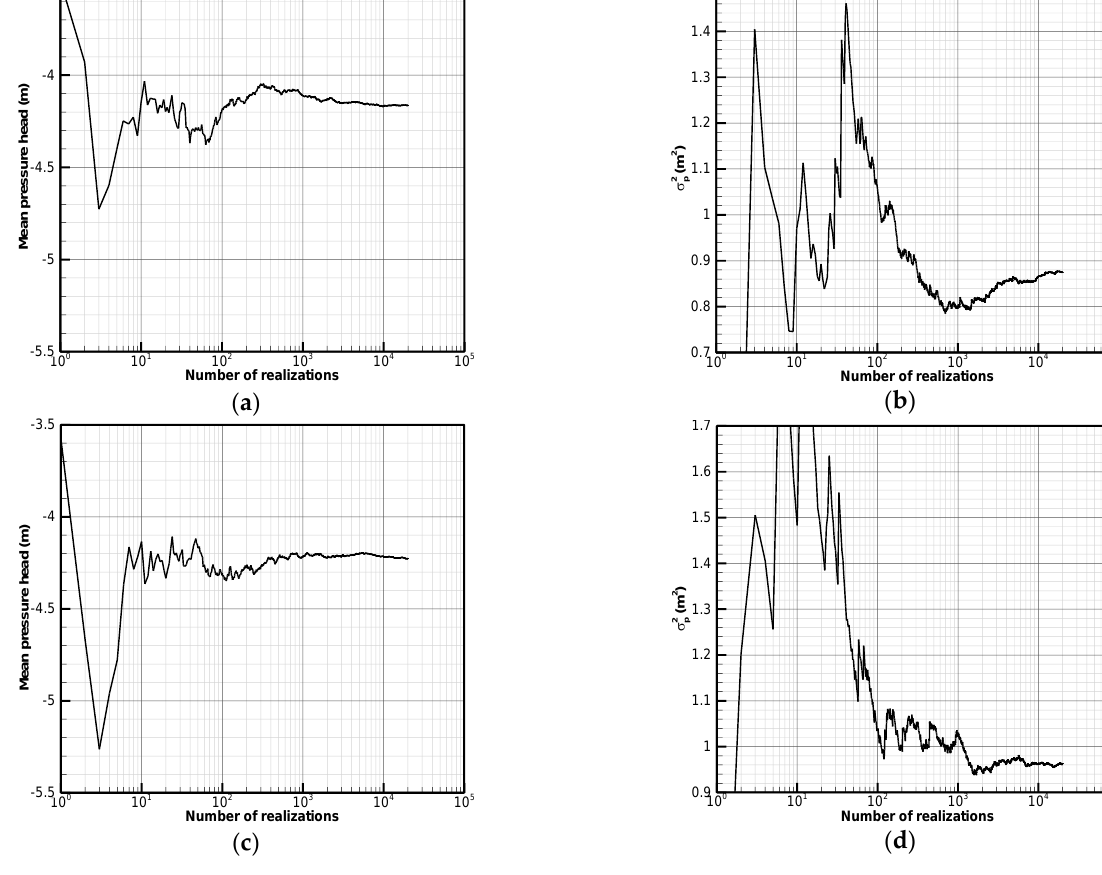
Figure 7. Convergence of the mean and variance of the pressure head of Point F (slope top) obtained by Monte Carlo simulation using two different grid densities: ( a , b ) are for Case 8 with the fine grid (50 × 40 cells) and ( c , d ) are for Case 9 with the coarse grid (25 × 20 cells). As can be seen in Figure 7a,b, the mean pressure head initially fluctuates with a maximum range from − 3.5 to − 4.7 m. With the increasing number of realizations, the fluctuation of the mean pressure head decreases. Finally, it keeps nearly steady after ap- proximately 3000 realizations. The variance of the pressure head can be observed to reach convergence after 10,000 realizations, with a maximum fluctuation of 0 to 1.46 m 2 . There- fore, the minimum number of realizations needed for Case 8 (a fine grid with 50 × 40 cells of random fields) to reach convergence was